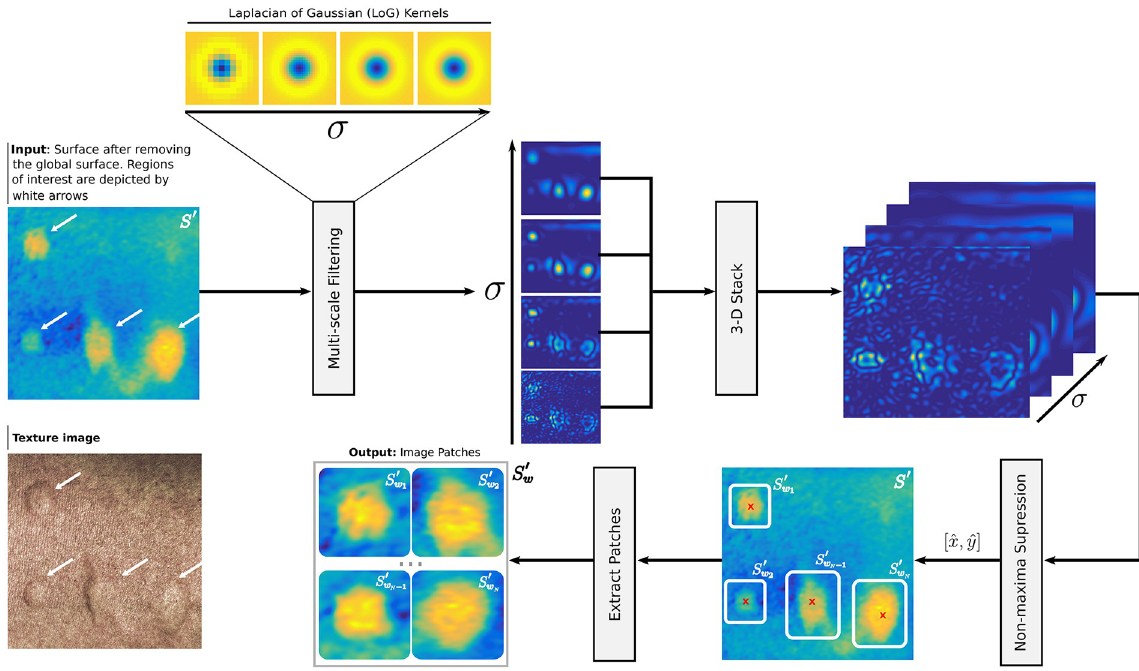
Fig 6. The Wheal Detection stage. S 0 and S 0 denote the surface after removing the global curvature of the forearm and the extracted surface w patches, respectively. We have included the texture image to highlight the correct detection of the wheals. This image has been digitally sharpened to improve the visualization of the